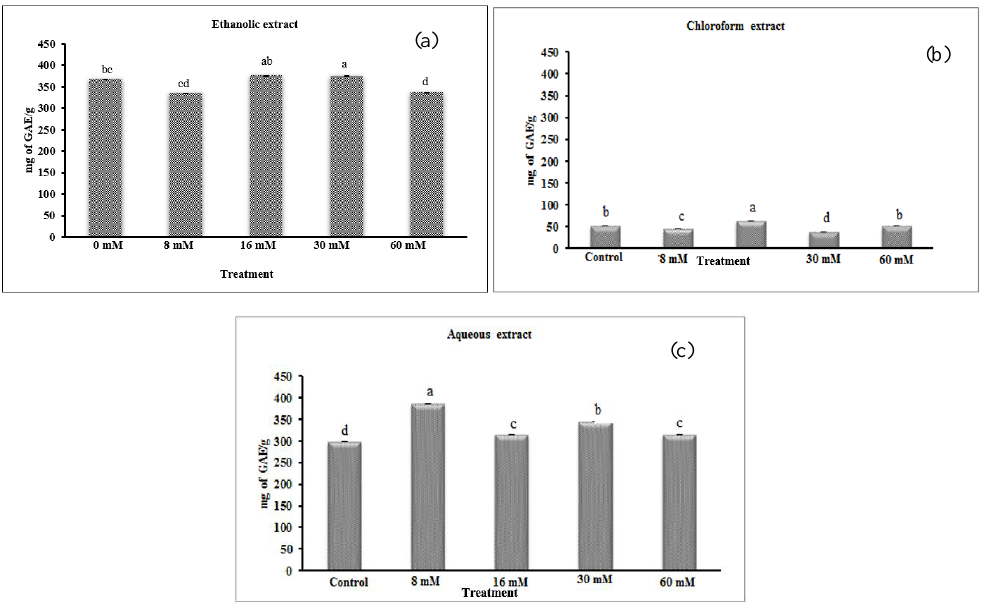
Figure 3. Effect of H 2 O 2 on total phenolic content in the leaf of Ficus deltoidea var deltoidea in different solvent extraction, (a) ethanolic extract, (b) chloroform extract and (c) aqueous extract. Bars indicate (±S.E). Different letters represent the significance at the 5% level of HSD test.